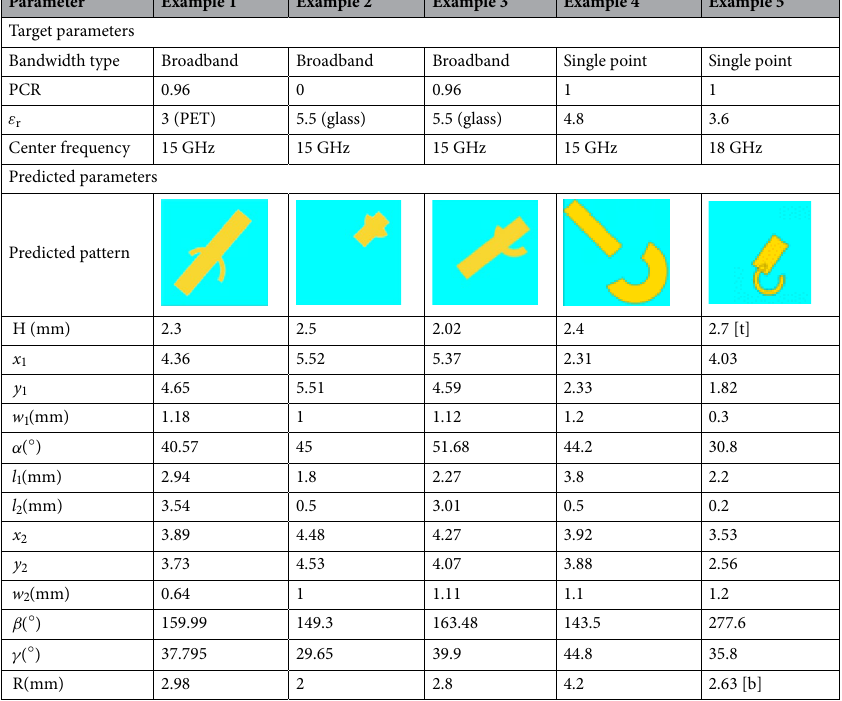
Table 5. Design of three samples with typical target PCR spectra.